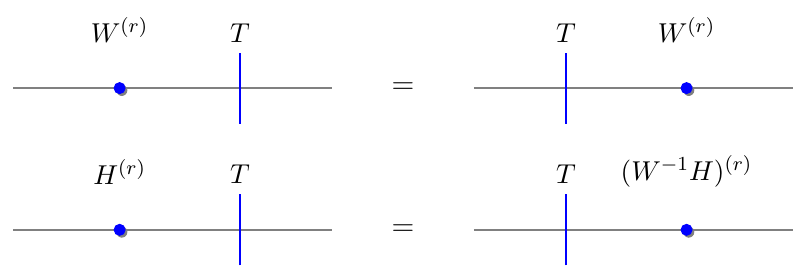
Figure 5 . A Wilson loop commutes with the T interface, whereas an ’t Hooft loop becomes a mixed Wilson-’t Hooft